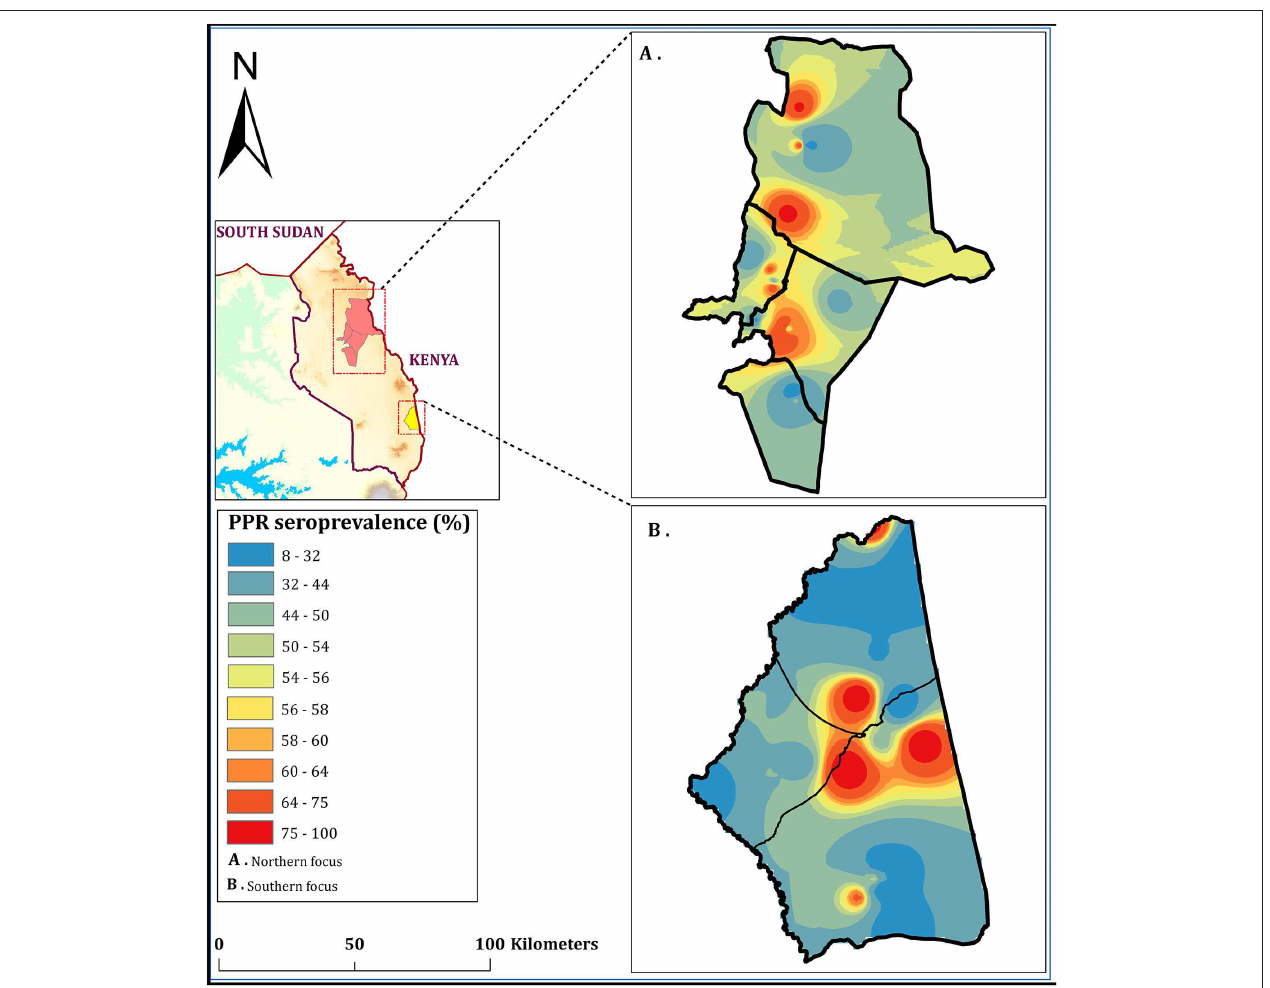
FIGURE 6 | Seroprevalence of PPR in Karamoja subregion (in set); May 2018. Shows the spatial distribution of PPR in the northern focus (A) and the southern focus (B) interpolated using 25 PPR point prevalence in each focus to create a focus-wide spatial effect. Interpolations were made using inverse-distance weighted (IDW) method using the Geostatistical Analyst tool in ArcMap ver. 10.5 software to produce a continuous PPR prevalence raster map on a spectral color